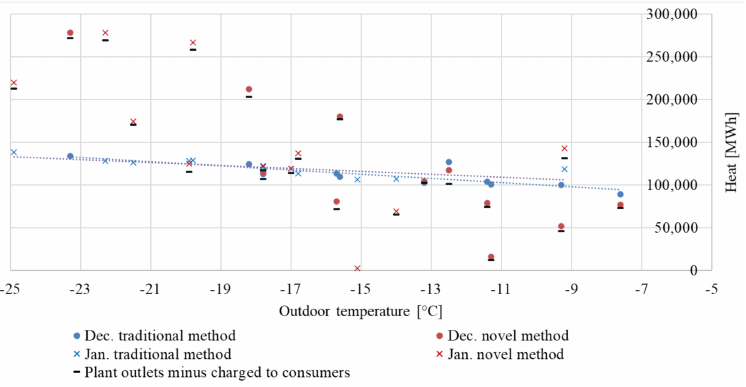
Figure 4. Surveyed and actual heat loss as a function of outdoor temperature.